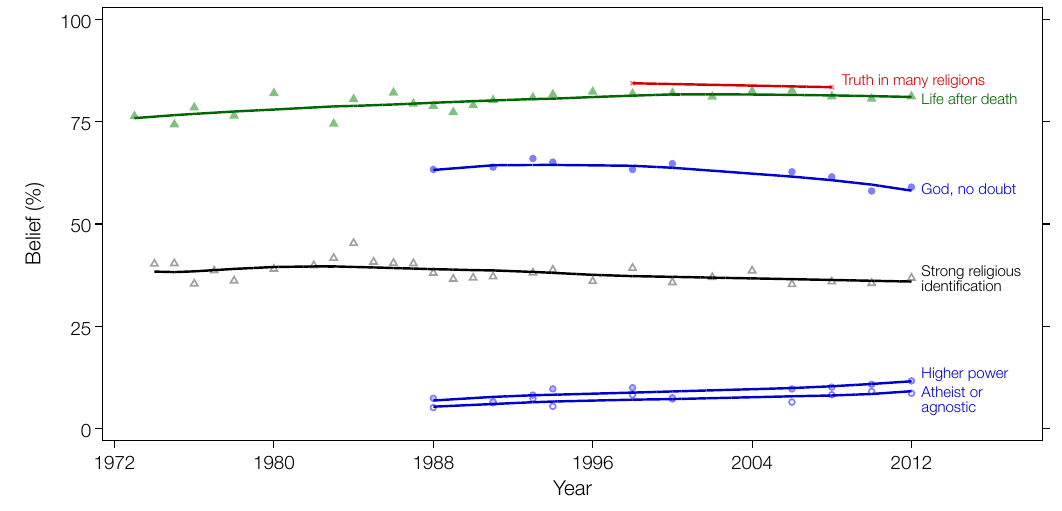
Figure 4: Selected Religious Beliefs by Year: Adults, United States, 1973–2012. Notes: Data smoothed by a locally estimated regression with a bandwidth of 0.8 for all but the “truths in religion” item (asked in only two years). Source: Authors’ calculations from General Social Surveys (Smith et al.